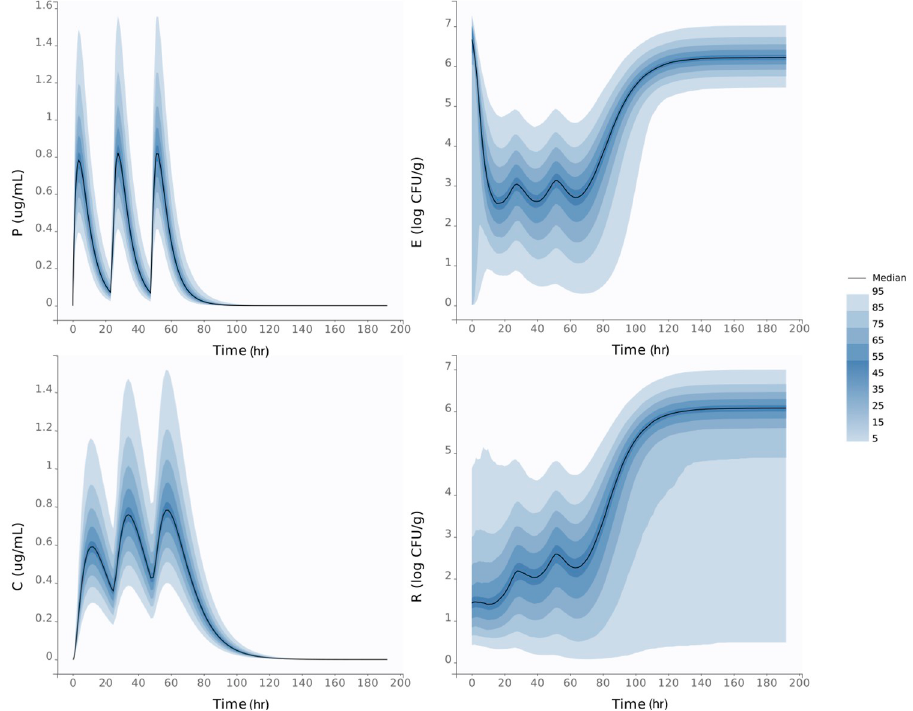
Fig 5. Low dose distributions. Predicted distribution of our model for the antimicrobial drug concentration throughout the GIT of the steer during the low dosing regimen. The top left panel is the plasma, the bottom left is the colon, top right is the total E. coli population and bottom right is the amount of E. coli above the ECOFF. In each panel, the dark line is the median, and the darkest blue region has a 50% likelihood, whereas the lighter colors are less likely to occur.